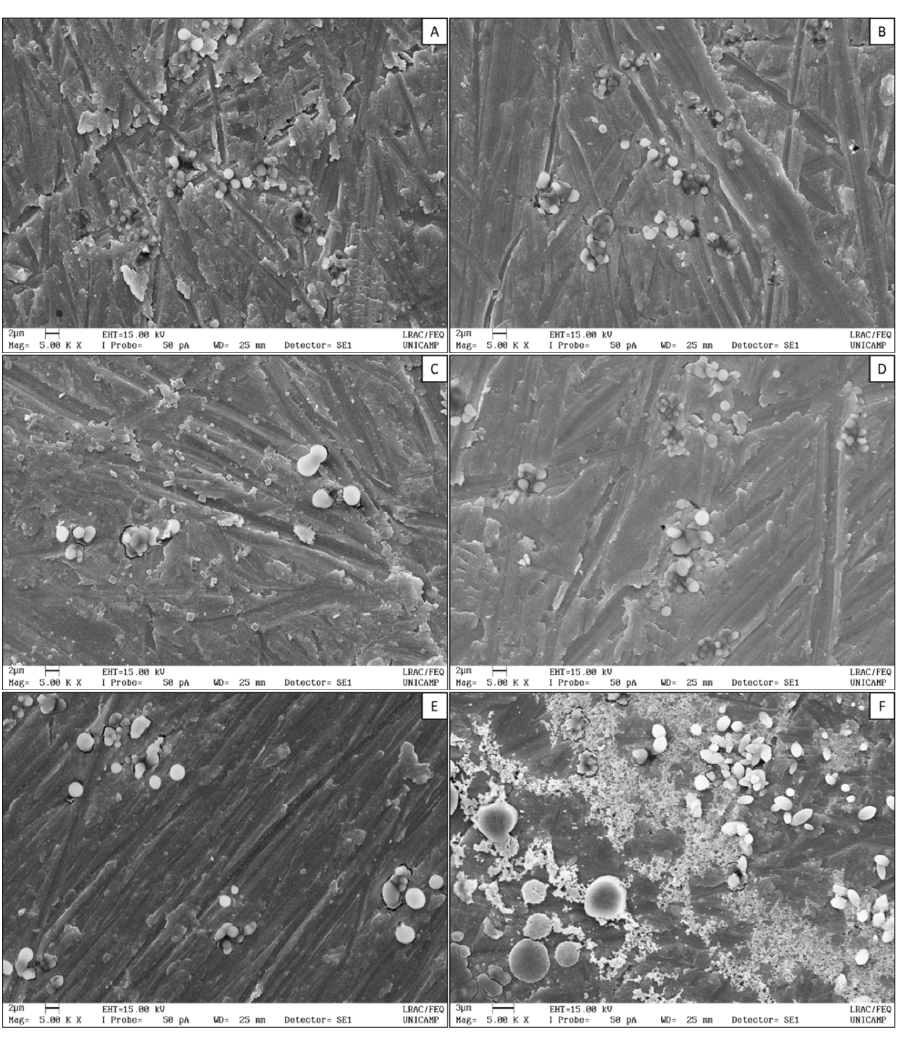
Figure 2. Scanning electron microscopy (SEM) images of LMW ( A ), LMW-B ( B ), LAC ( C ), LAC-B ( D ), SHR ( E ), and SHR-B ( F ) nanoparticles. LMW = low molecular weight chitosan nanoparticles; LAC = chitosan oligosaccharide lactate nanoparticles; SHR = chitosan from shrimp shells nanoparticles; B = bromelain. The backgrounds of the SEM pictures are artefacts introduced from the sample preparation.